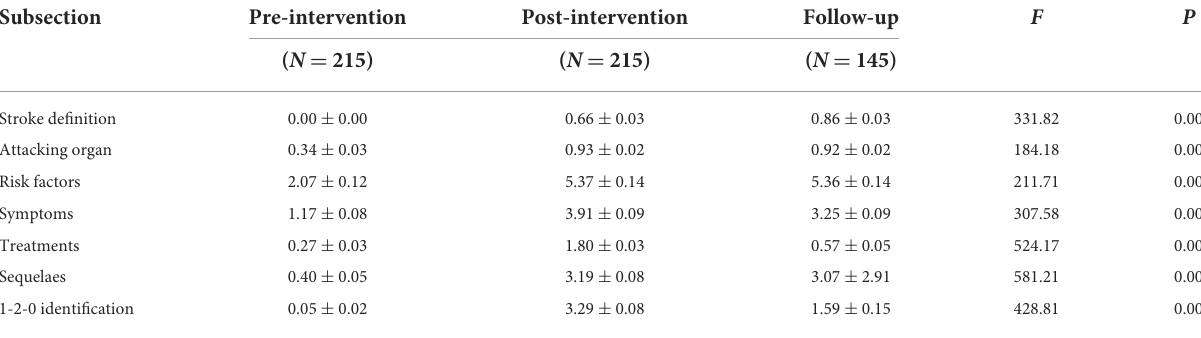
TABLE 2 The pre-intervention, post-intervention, and follow-up evaluation of stroke knowledge score of primary school students for stroke in Dali, Yunnan, China (means ± SD).